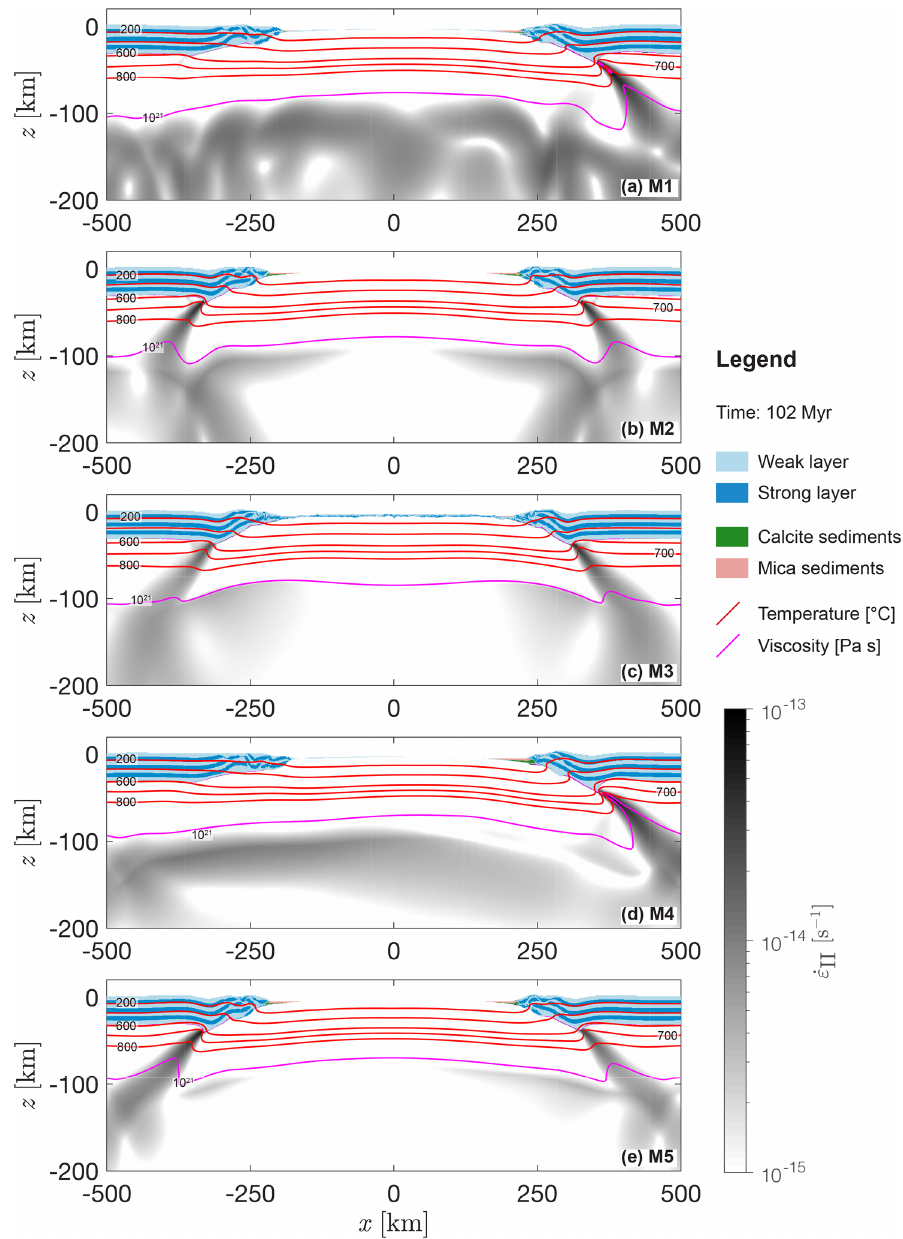
Figure 9. Stage of subduction initiation. (a–e) Results of models M1–5 after 102Myr of simulated deformation. Blue indicates mechanically weak (light) and strong (dark) crustal units, and green and salmon indicate the sedimentary units (only minor volumes in trench regions). White to black colours indicate the second invariant of the strain rate tensor field calculated by the numerical algorithm. Red lines show levels of several isotherms, and the magenta line shows the level of the 10 21 Pas viscosity isopleth. This contour line approximately represents the mechanical transition between the mantle lithosphere and the convecting upper